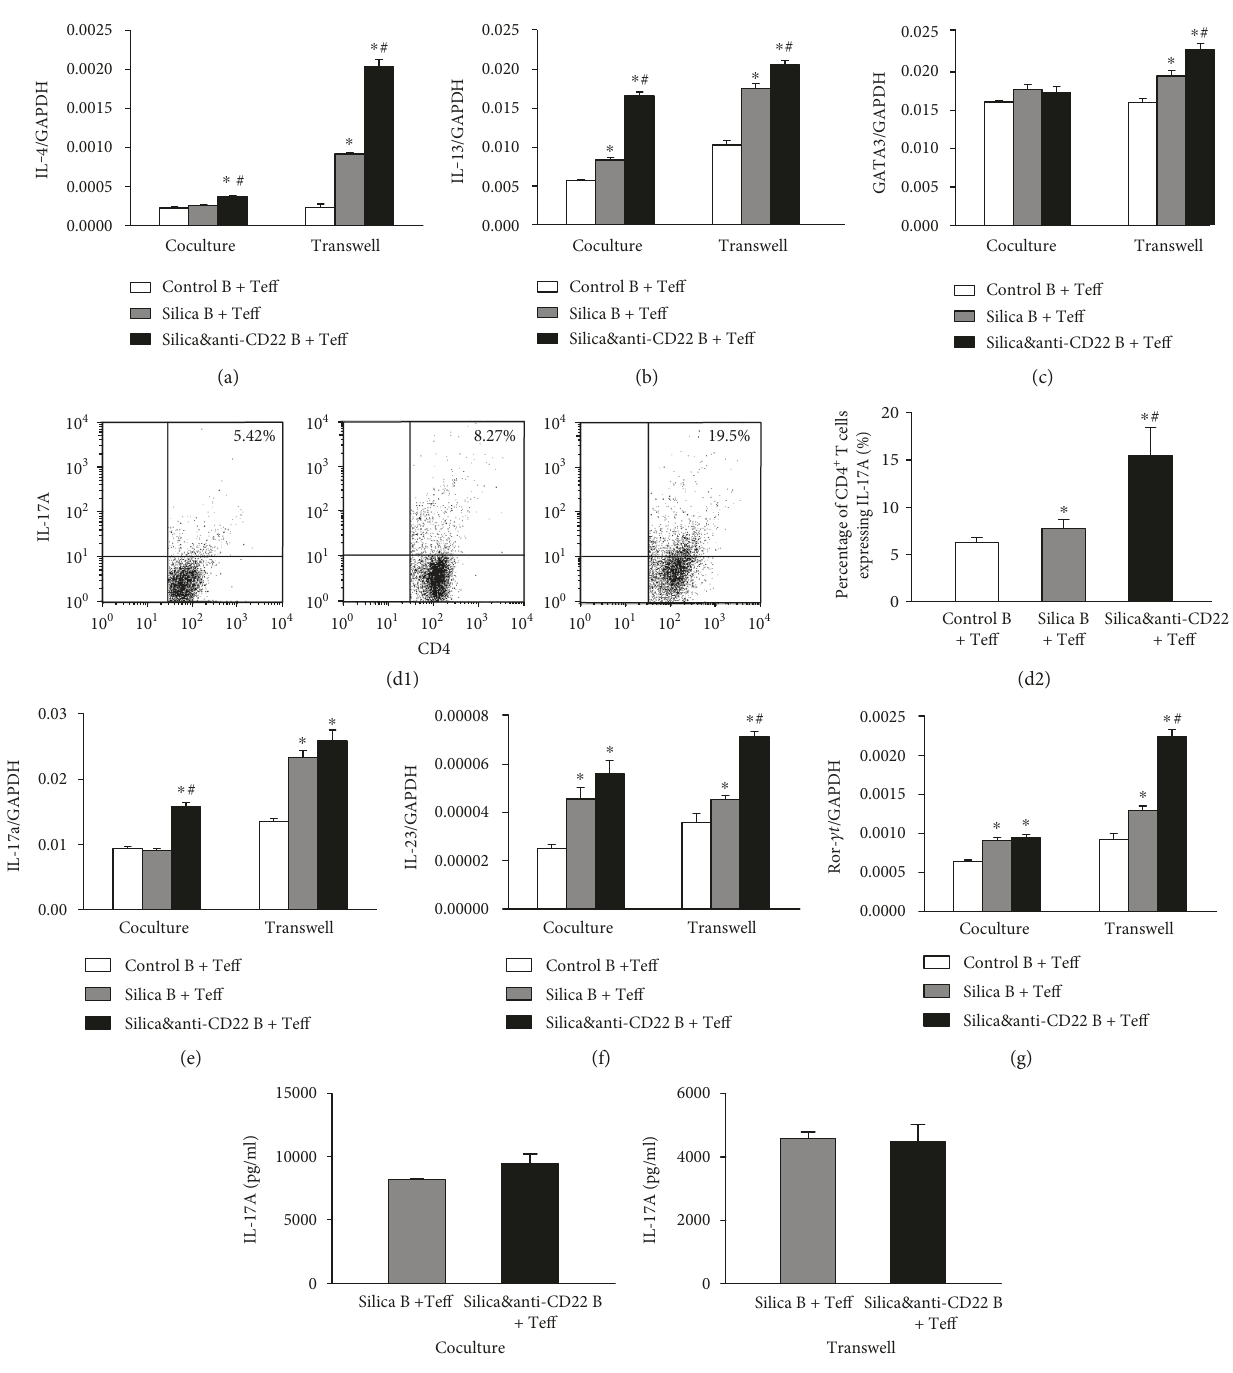
Figure 3: Insu ffi cient B10 promoted the Th2/Th17 responses in the Te ff and B coculture system in vitro. (a, b, c) The expressions of IL-4, IL-13, and GATA3 in di ff erent groups of the B cell and Te ff coculture system with or without insert plates were assayed by real-time PCR. (d1, d2) The percentages of CD4 + IL-17A + Th17 cells in di ff erent groups of the B cell and Te ff coculture system were studied by fl ow cytometry. (e, f, g) The expressions of IL-17A, IL-23, and ROR- γ t in di ff erent groups of the B cell and Te ff coculture system with or without insert plates were assayed by real-time PCR. (h, i) The secretions of IL-17A in supernatant of the B cell and Te ff coculture system with or without insert plates were assayed by CBA. (Data was presented as mean ± SEM ( n = 5 ). ∗ p < 0 05 , signi fi cantly di ff erent compared with the control B+Te ff group. # p < 0 05 , signi fi cantly di ff erent compared with the silica B+Te ff